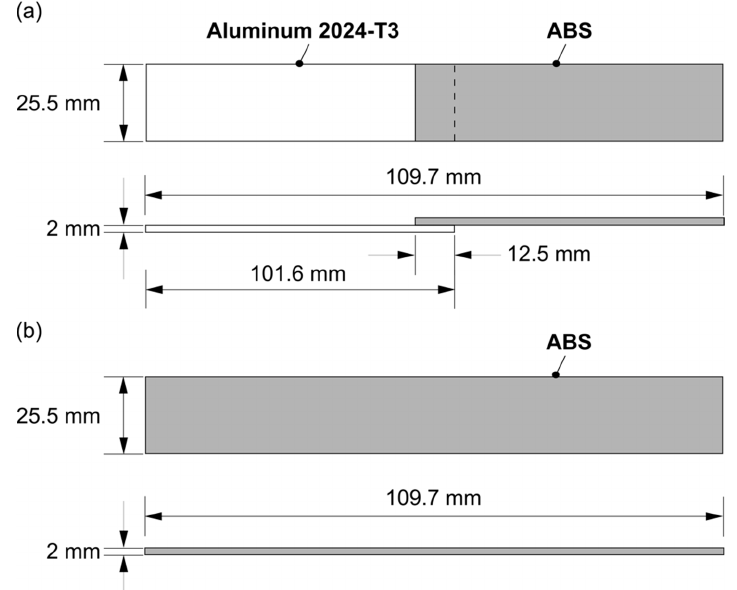
Figure 4. Scheme from the specimen geometry for the ( a ) AddJoining hybrid joints and ( b ) ABS BM FDM.